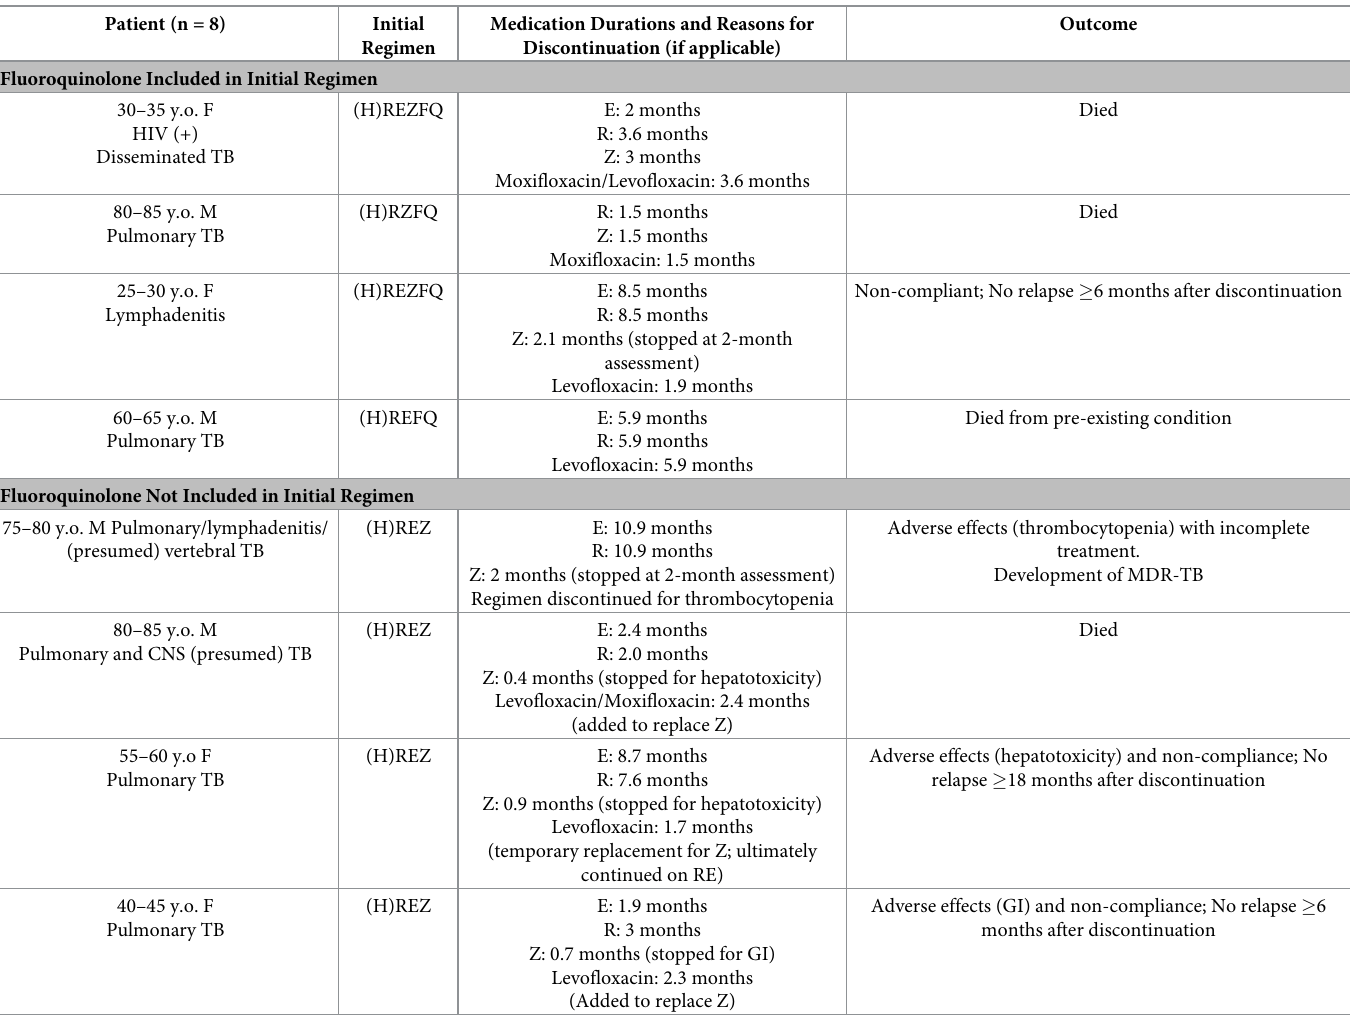
Table 3. Patients with unsuccessful